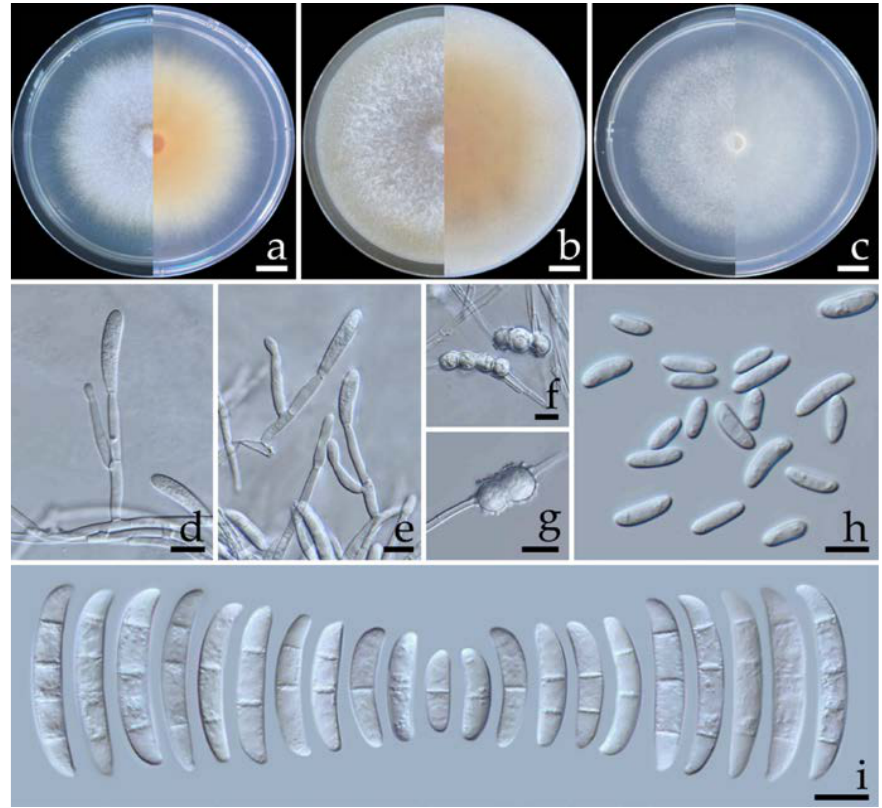
Figure 5. Fusarium paranaense (SDBR-CMU463). Colony on potato dextrose agar ( a ), oatmeal agar ( b ) and synthetic nutrient-poor agar ( c ) (left, surface view and right, reverse view) after incubation at 25 °C for seven days. Conidiophores on aerial mycelium ( d ). Phialides on aerial mycelium ( e ). Smooth and rough-walled chlamydospores ( f , g ). Aerial microconidia ( h ). Aerial macroconidia ( i ). Scale bars: ( a – c ) = 10 mm; ( d – i ) = 10 µm. Colonies on OA, PDA, and SNA grew to 80–83, 75.0–78.0, and 77.0–80.5 mm in di- ameter, respectively, at 25 °C in the dark for one week. Colonies on PDA were orange– white in the center, white at the margins, and flat with entire edges that were light yellow. Colonies on OA were brownish orange in the center and white at the margins with aerial mycelia that were dense and flat with entire edges that were brownish orange. Colonies on SNA were white and raised with entire edges that were white. Pigment and odor were not present. Sporodochia were not found in any agar media. Conidiophores were formed on aerial mycelium, of a size of 12–105 × 2.5–4.1 µm, were verticillately branched, and bore terminal or lateral phialides. Phialides were monophialidic, subulate to sub-cylindrical, hyaline, smooth and thin-walled, and of a size of 10.8–38.9 × 2.3–5.4 µm. Chlamydospores were abundant, hyaline, globose, intercalarily or terminal, ellipsoid, smooth to rough- walled, solitary, or were present in pairs or formed chains, and of a size of 6.2–11.3 × 6.2– 11.6 µm (av. ± SD: 9.2 ± 1.4 × 8.9 ± 1.3 µm). Microconidia were abundant, hyaline, thin- walled, elongated to ellipsoidal, straight to slightly curved, aseptate, and of a size of 5.3– 20.1 × 2.3–5.2 µm (av. ± SD: 11.4 ± 3.4 × 4.0 ± 0.7 µm). Macroconidia were hyaline, cylindri- cal to fusiform, 1–4-septate, and of a size of 16.0–40.6 × 3.5–5.4 µm (av. ± SD: 29.1 ± 6.5 × 4.7 ± 0.4 µm). Note: The morphological characteristics of isolates SDBR-CMU463 and SDBR- CMU464 corresponded to descriptions of F. paranaense [50]. Phylogenetically, F. paranaense forms a sister taxon to F. falciforme ; however, the growth of F. paranaense appeared to be slower than that of F. falciforme (85.0 mm) on PDA for one week at 25 °C [18]. In addition,